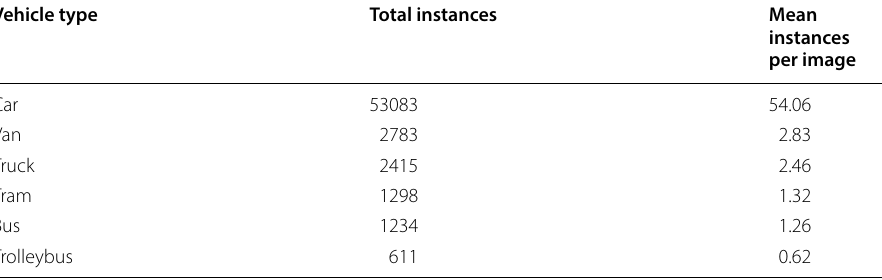
Table 1 Data distribution in the collected